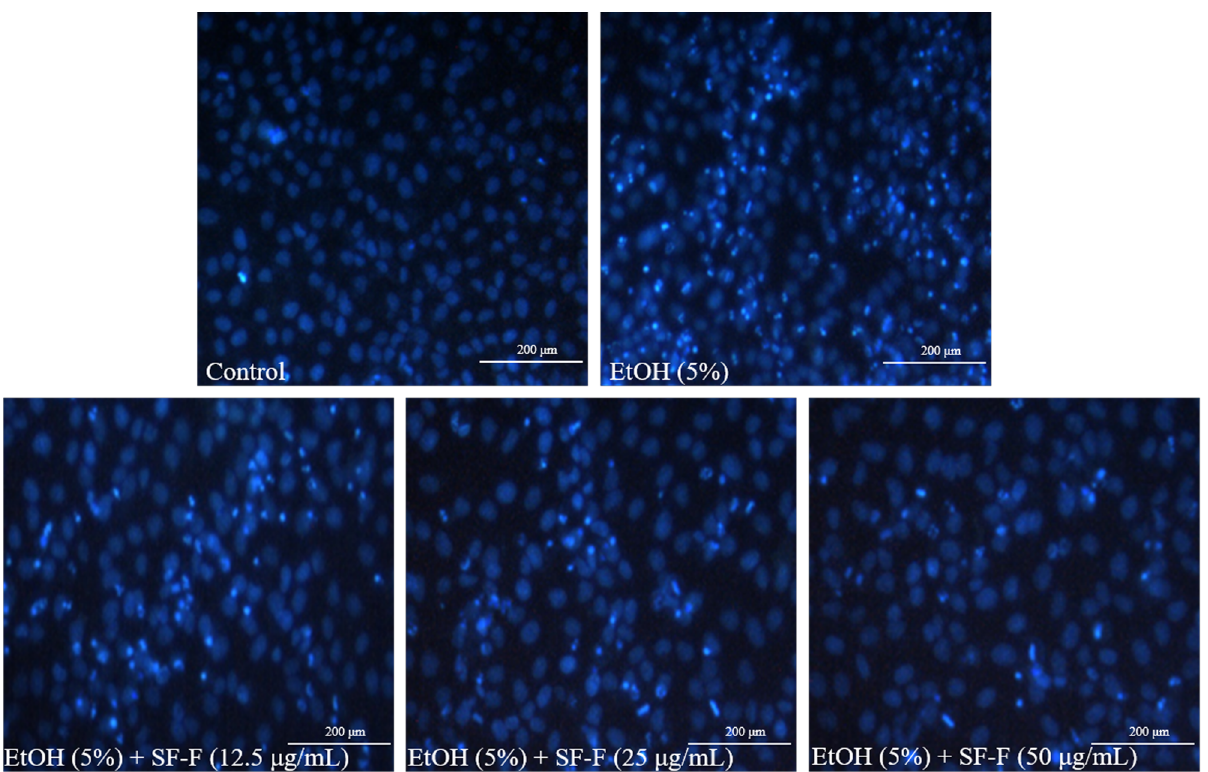
Figure 2. Protective effect of SF-F against EtOH-induced apoptosis in Chang liver cells. The apoptotic body formation was observed under a fluorescence microscope after Hoechst 33342 staining.